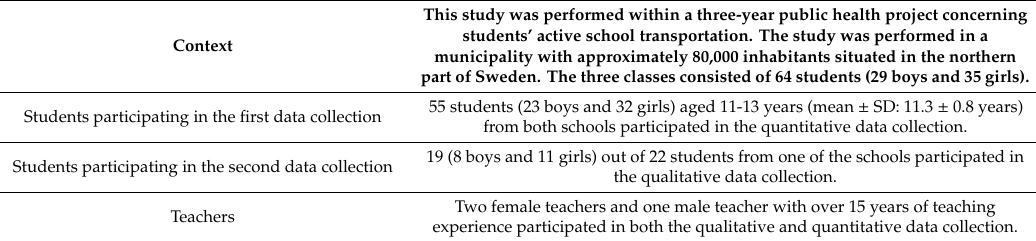
Table 1. Characteristics of the context, students, and teachers who participated in the